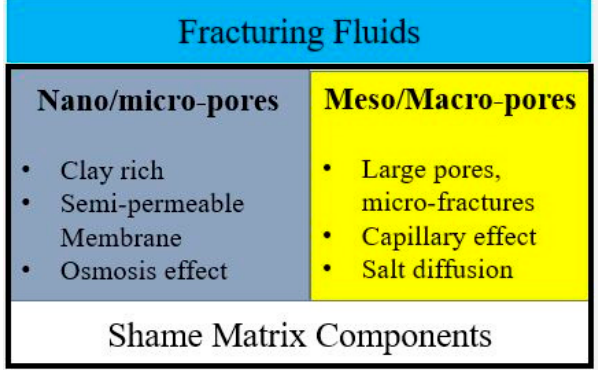
Figure 6. Numerical model with imbibition and osmosis coupling. Table 1. Imbibition mechanisms for different models that considered imbibition and osmosis. Model